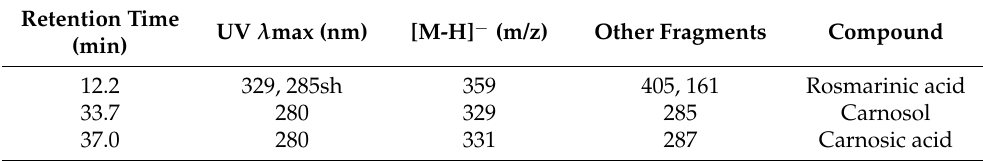
Table 3. Identification of the main peaks in sage solid